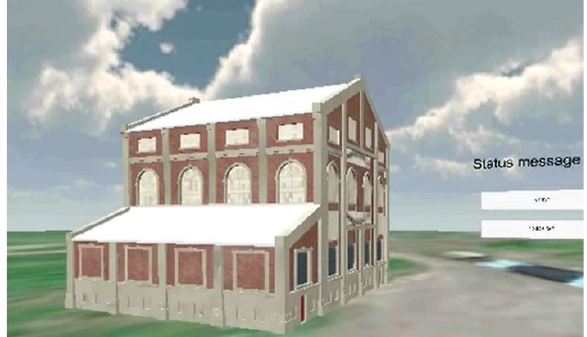
Figure 11. Hoist Engine house 3D model